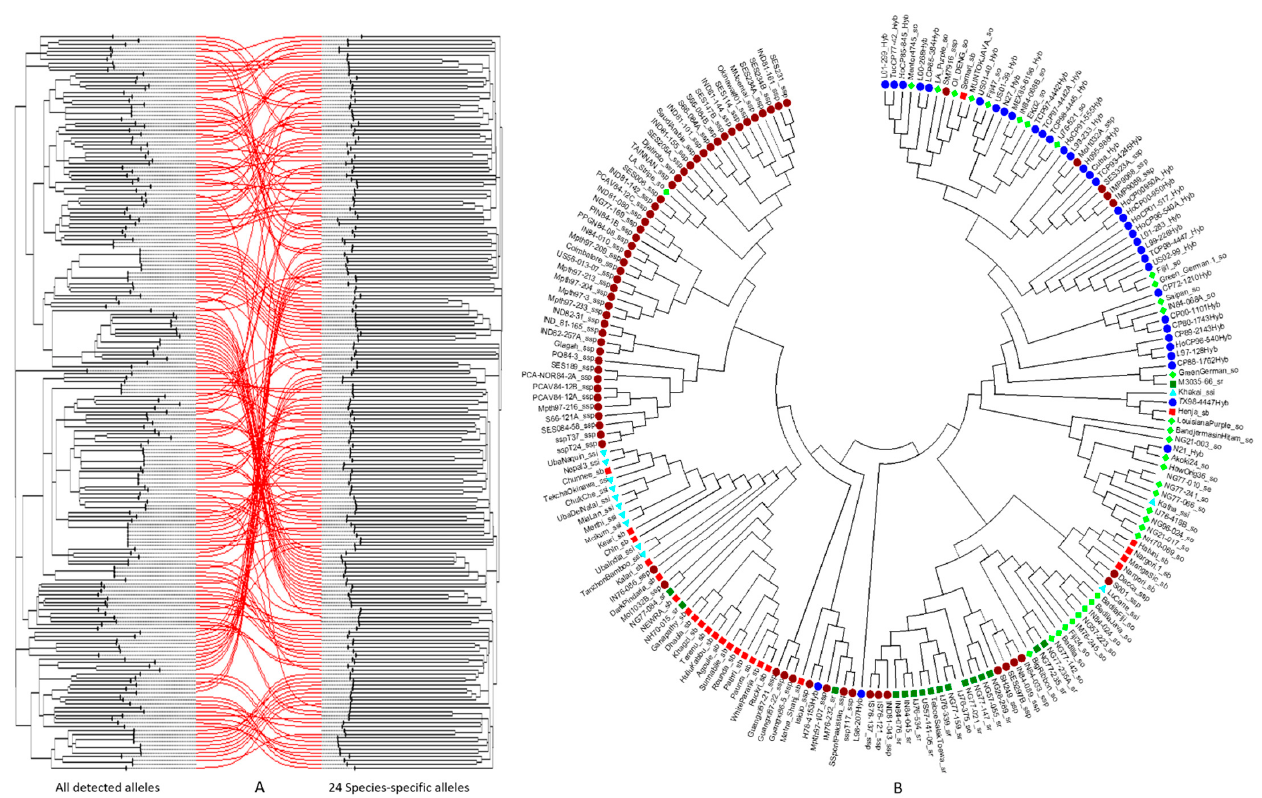
Figure 5. A: Two phylogenetic trees of 196 accessions constructed using all 624 SSR alleles vs. 24 Species-specific alleles created from MEGA 7 based on 24 species-specific or species-associated alleles. B: Circled phylogenetic tree of 196 accessions created by 24 species-specific or species- associated alleles with the labels as S. spontaneum (tan round), S. robustum (green square), S. officinarum (green diamond), S. sinense (blue triangle), S. barberi (red square), S. edule (white round), and Saccharum spp. hybrids (blue round).